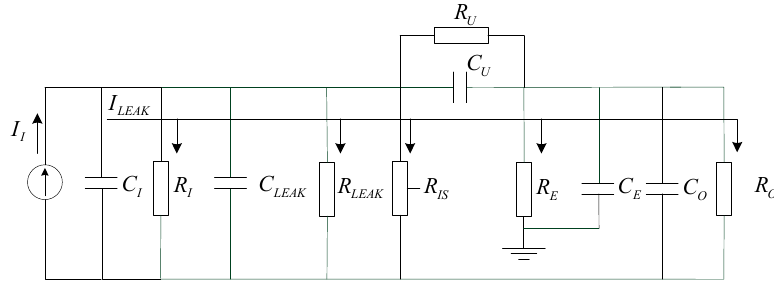
Figure 4. The equivalent model of the space charge density measurement device.